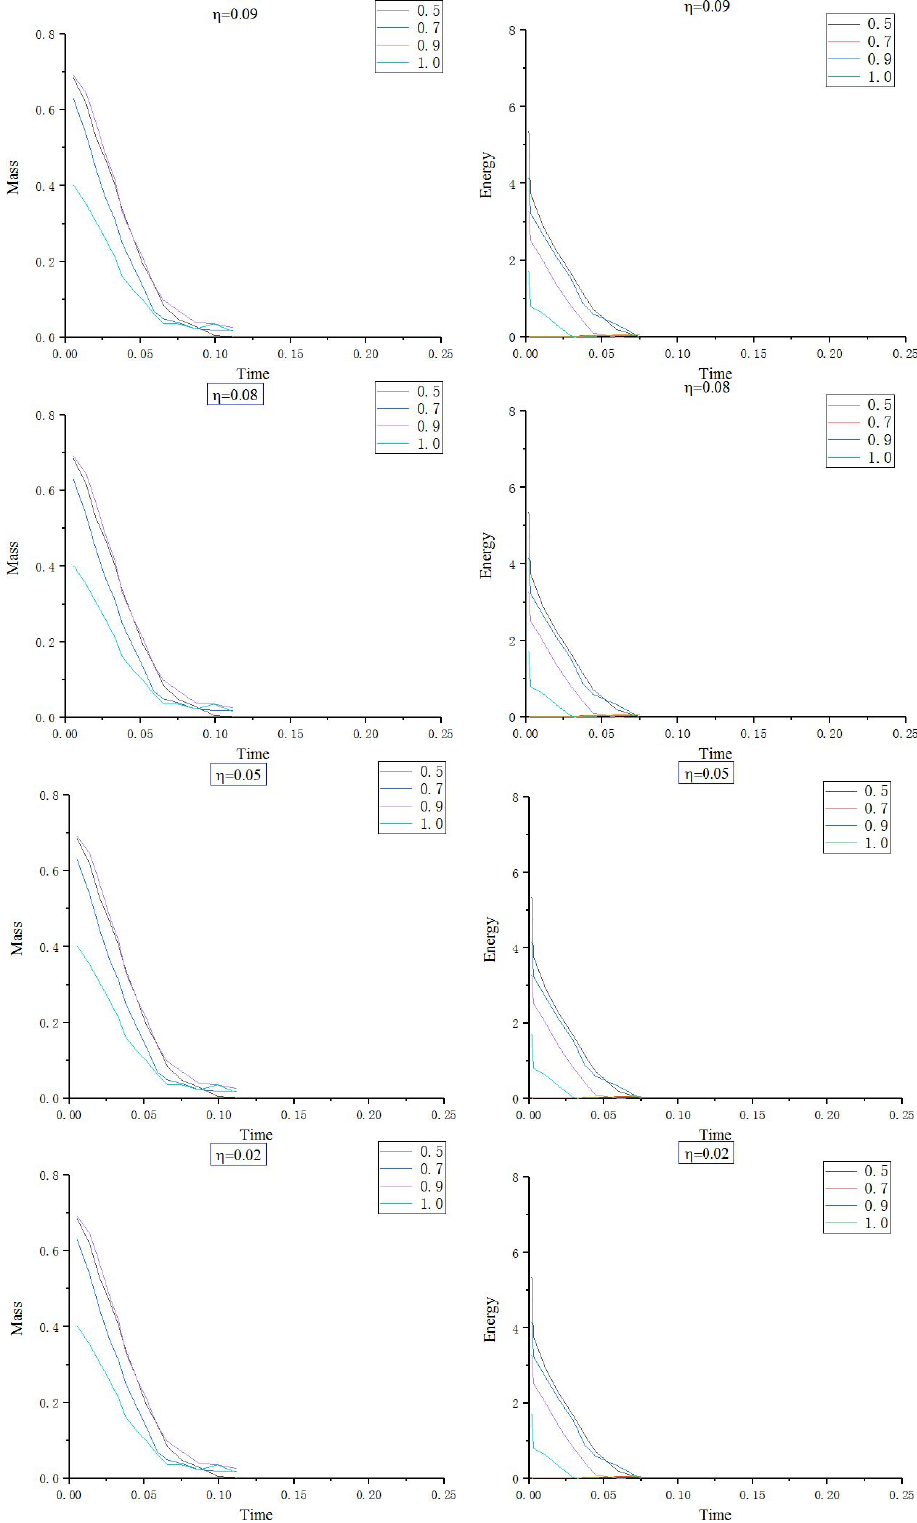
Fig. 2 Mass and time evolution diagram of one-dimensional time-fractional Allen-Calm